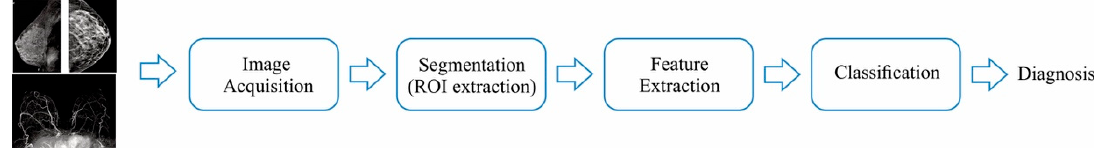
Figure 1. BC detection using image processing strategies.